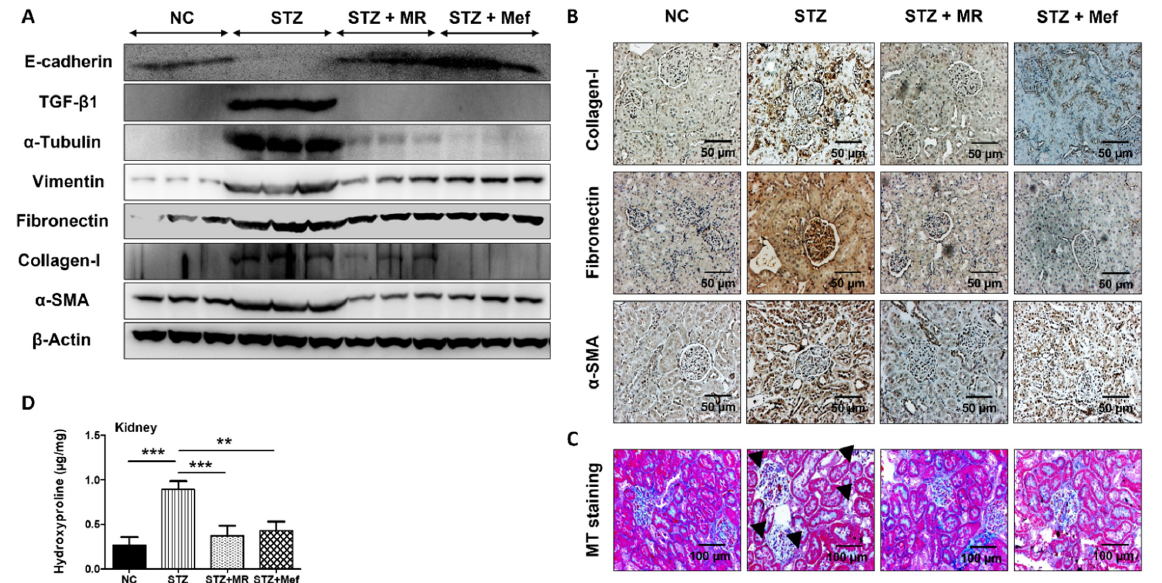
Figure 4. Effects of the MR extract on expression of renal fibrosis biomarkers in STZ-treated rats. ( A ) Expression pattern of E-cadherin, TGF- β 1, α -tubulin, vimentin, fibronectin, collagen-1, and α -SMA in the kidney of rats, as determined by western blotting. β -Actin was used as the loading control. The results represent three independent experiments. ( B ) Immunohistochemical analysis of collagen-I, fibronectin, and α -SMA in the kidneys of animals from all groups. Original magni- fication: 200 × , scale bar: 50 µ m. ( C ) Images of kidney sections stained with Masson’s